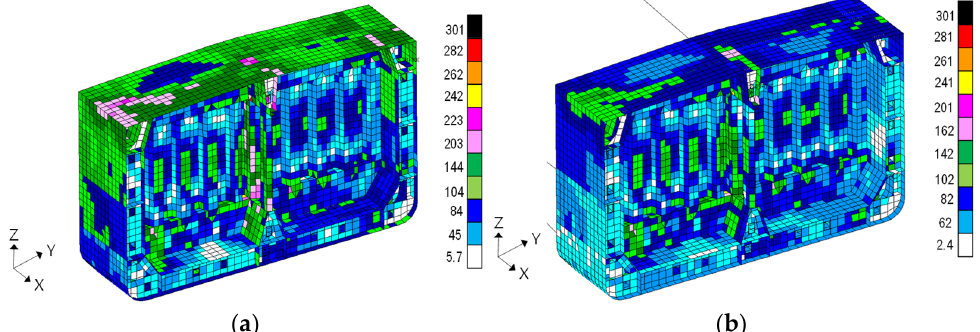
Figure 12. Detailed stress contour between the center bulkhead with stools and inner structure in the cargo hold. ( a ) Hogging combination. ( b ) Sagging